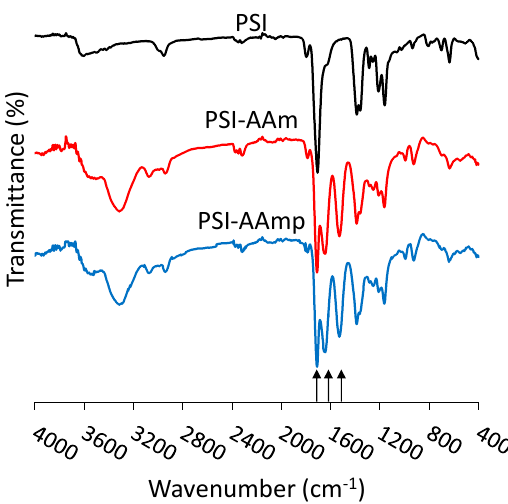
Figure 3. FTIR spectra of PSI, PSI-AAm and PSI-AAmp, where arrows from left to right indicate 1709, 1662, 1530 cm − 1 .